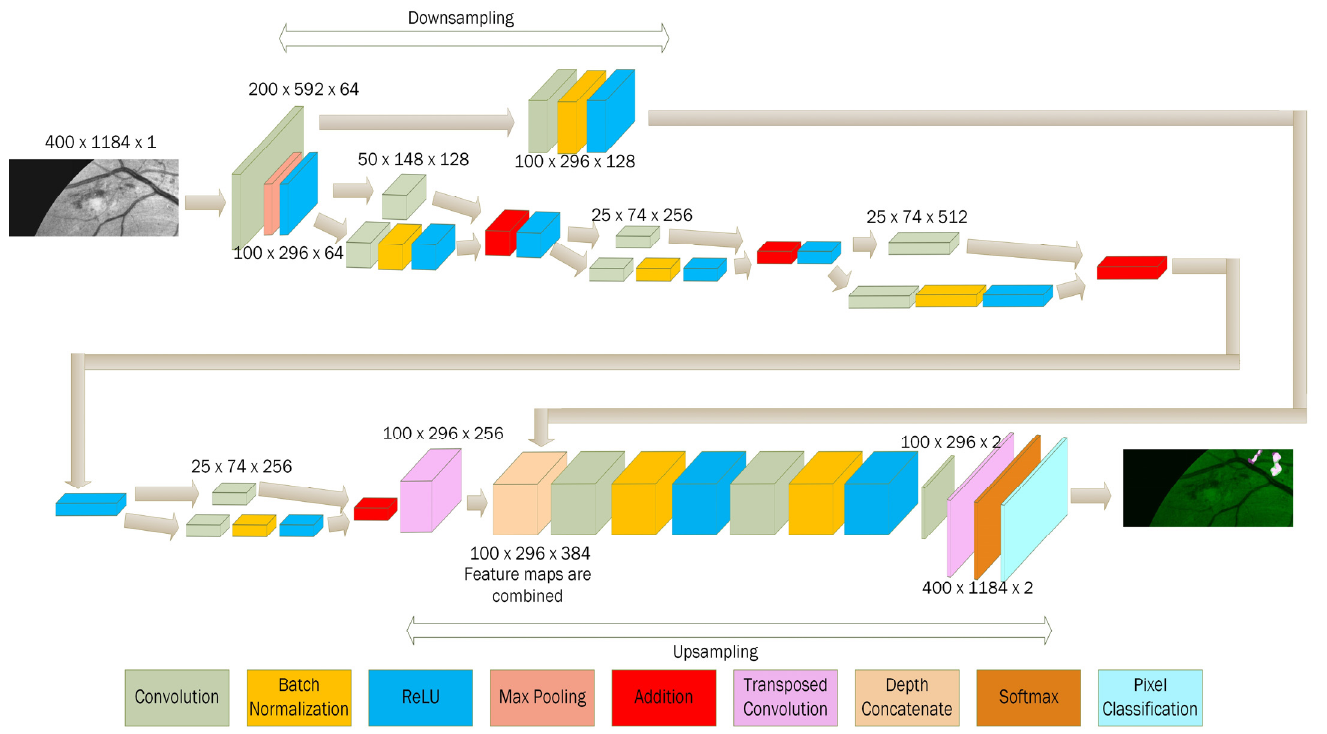
Figure 6. The structure of the network architecture.